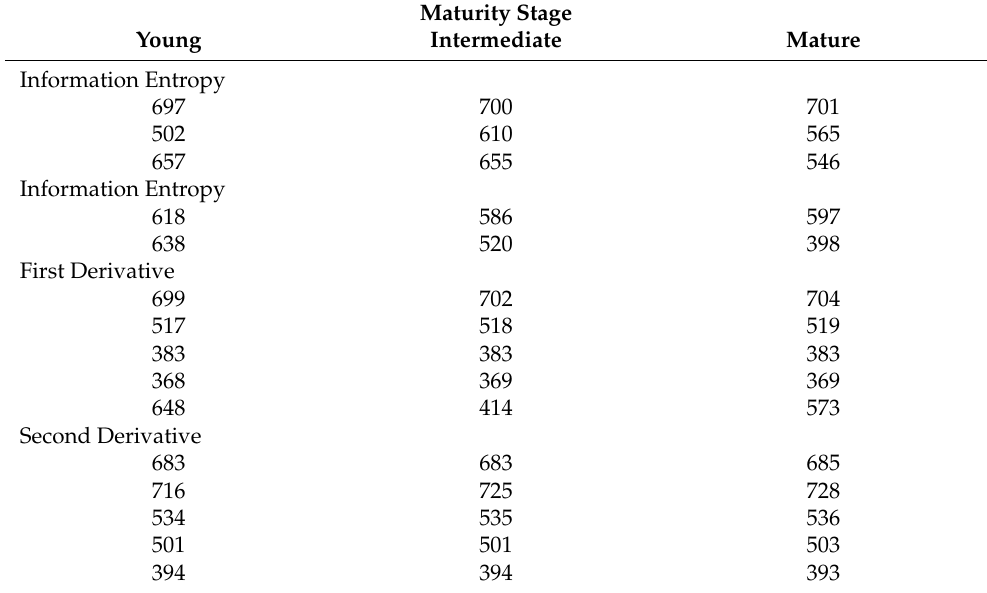
Table 2. Five most significant wavelengths (nm) selected for discrimination among macronutrient deficiencies in flue-cured tobacco ( Nicotiana tabacum L.) at three growth stages. Band selection methods included information entropy, first spectral derivative, and second spectral derivative.